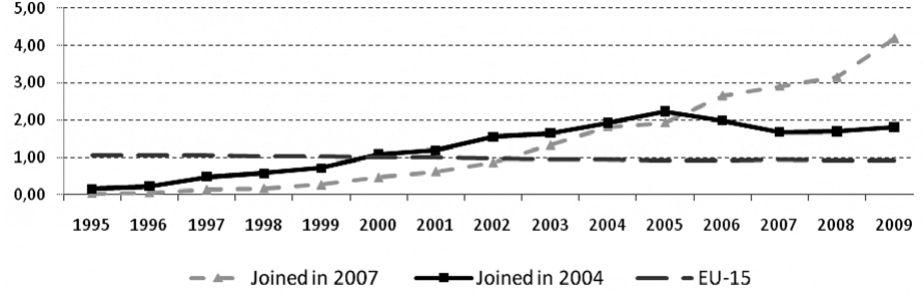
Fig. 3. Comparative evolution of the Certification Intensity of ISO 9000 in the EU Source: Own preparation on the basis of the various executive reports on the global statistics for ISO 9000 published by ISO